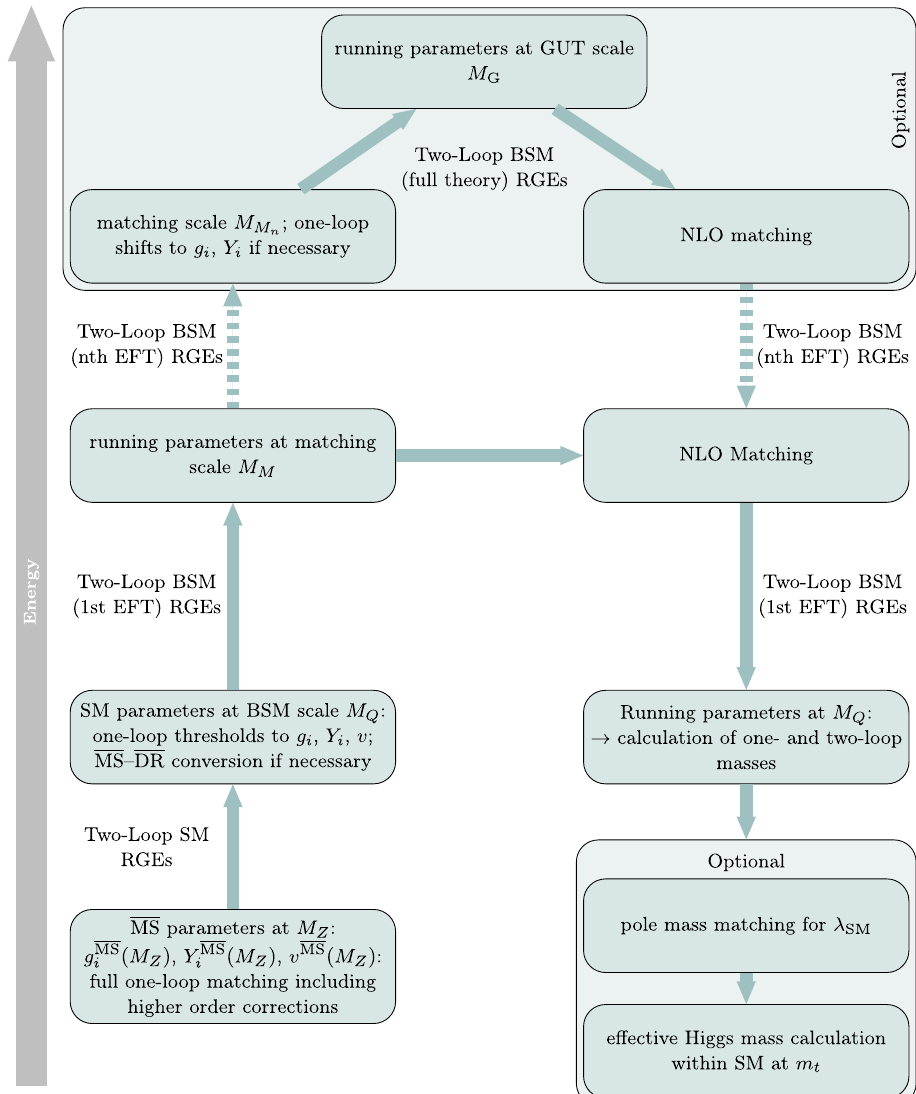
Fig. 6 Schematic procedure of the numerical evaluation of a parameter point with SPheno when using the numerical setup to calculate matching conditions and implement them in